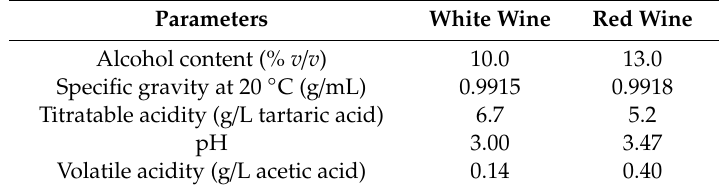
Table 1. Physicochemical characteristics from the white and the red wines used in the